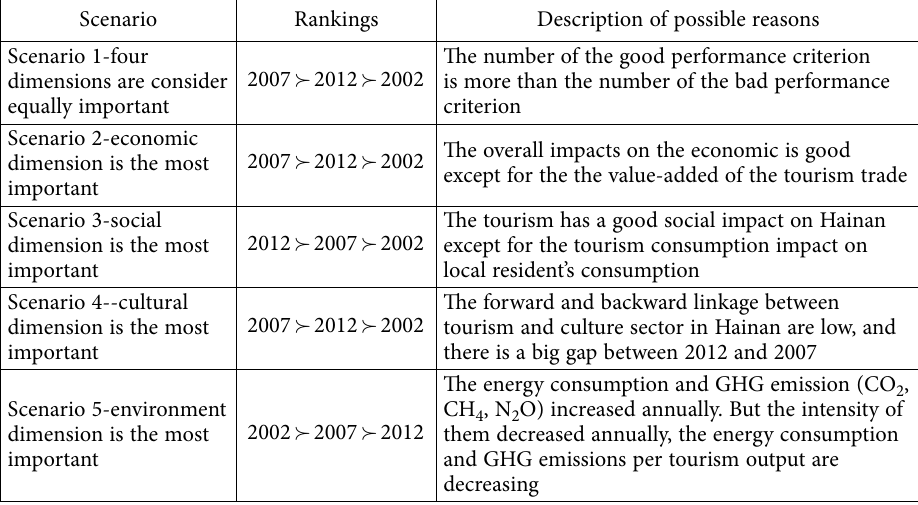
Table 10. The results of sensitivity analysis using different scenarios and reasons Scenario Rankings Description of possible reasons